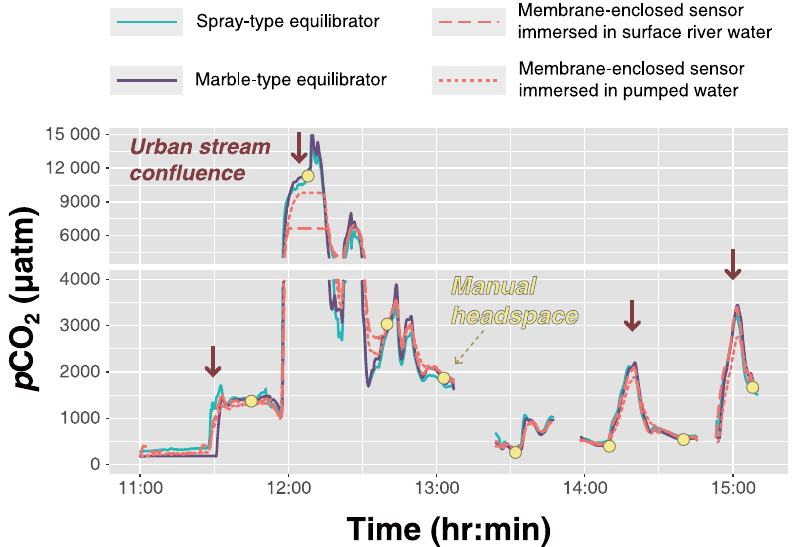
Figure 5. Continuous underway measurements of p CO 2 using a spray-type equilibrator, a marble-type equilibrator, and two membrane- enclosed sensors along the tidal reach of the Han River from 11:00 to 15:00, 11 May 2015. The inflow of urban streams containing high loads of organic matter, inorganic nutrients, and CO 2 is indicated by brown arrows. The p CO 2 measurements, using manual headspace equilibration (yellow circle) were performed on board. Note that the membrane-enclosed sensors did not capture drastic increases in p CO 2 after 12:00 because of the upper detection limit of the sensors (7000 or